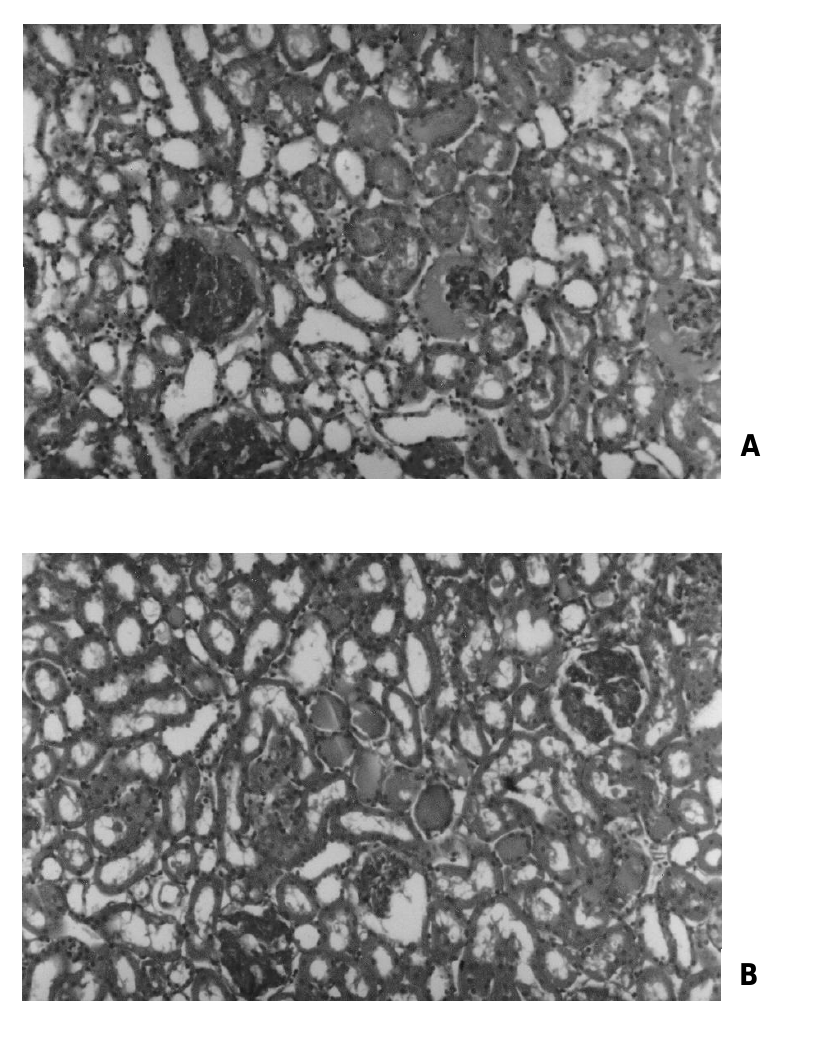
Figure 3. Action of the antivenom (1 µg/mL) on effects of Thalassophryne nattereri venom (1 µg/mL). The group that received venom only showed a moderate deposit of proteinaceous material in the tubules and urinary space ( A ). The kidneys perfused with venom plus antivenom presented a mild deposit of proteinaceous material in glomeruli and tubules ( B ). Hematoxylin-eosin stain (20x). Canon PowerShot A 95, 5.0